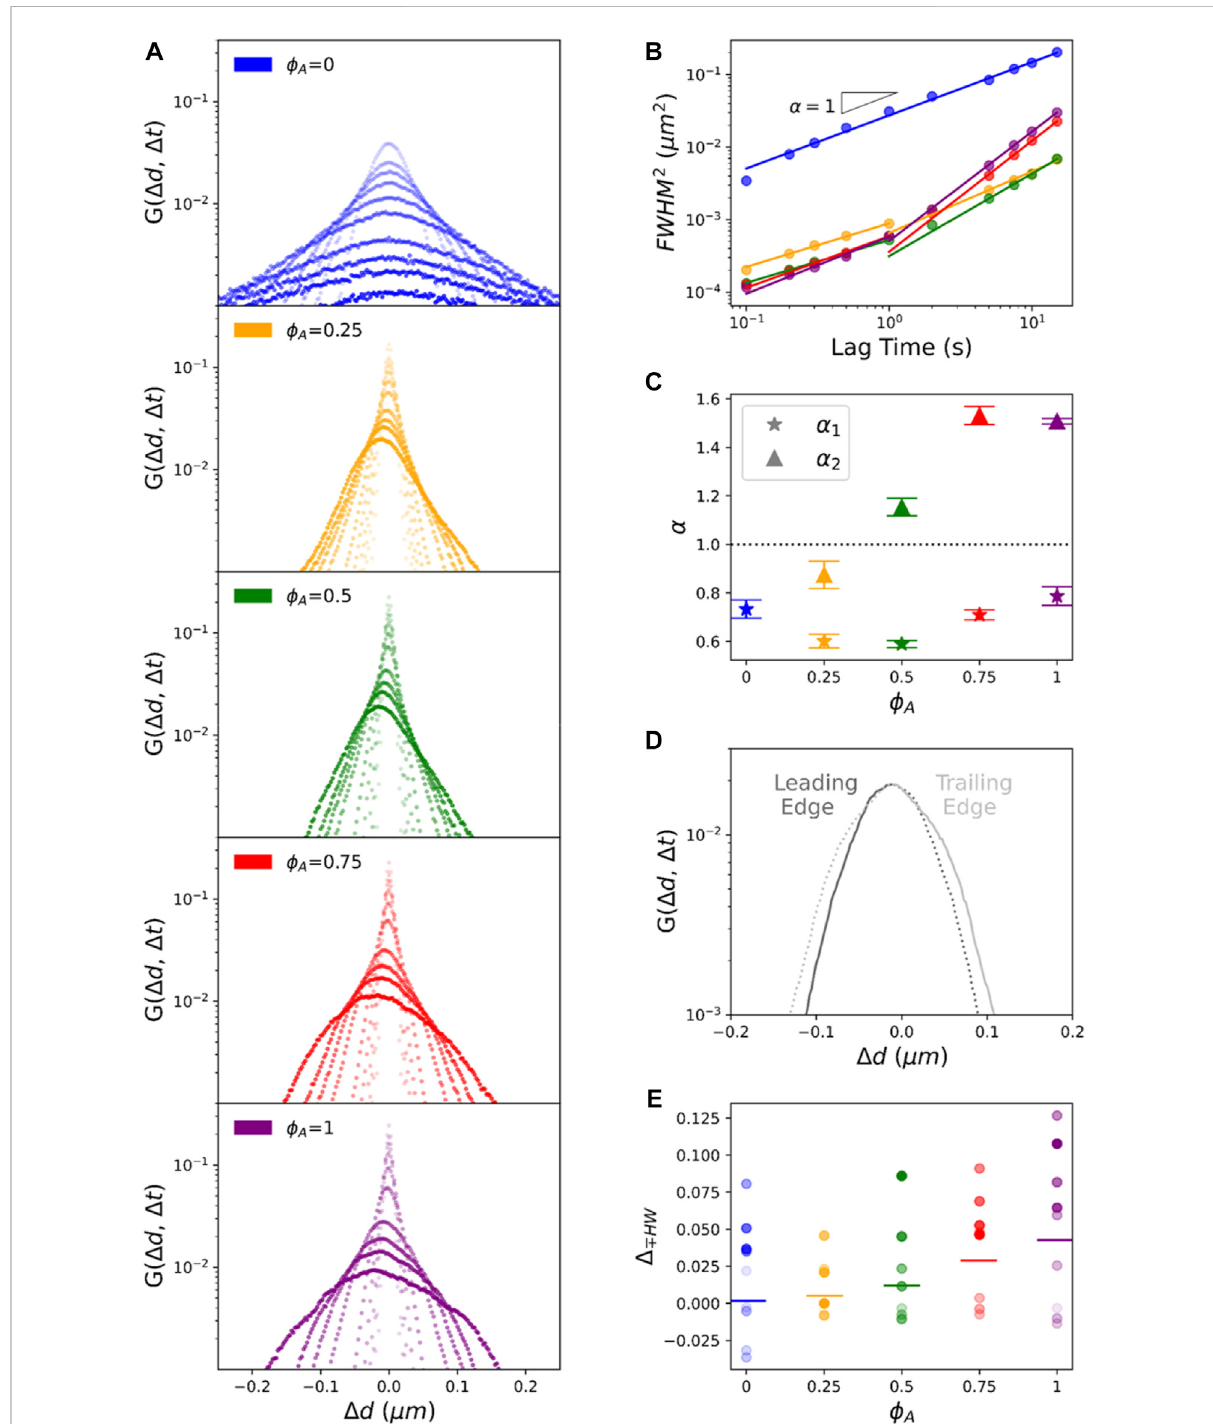
FIGURE 3 Asymmetric non-Gaussian van Hove distributions reveal a combination of heterogeneous subdiffusion and advective transport of particles in active composites. (A) van Hove distributions G ( Δ d , Δ t ) of particle displacements Δ d (cid:2) Δ x ∪ Δ y , measured via SPT, for lag times Δ t (cid:2) 0 . 1 , 0 . 2 , 0 . 3 , 0 . 5 , 1 , 2 , 3 , 5 , 10 , 15 s denoted by the color gradient going from light to dark for increasing Δ t . Each panel corresponds to a different composite demarked by their ϕ A value with color-coding as in Figure 2. (B) The square of the full width at half-maximum ( FWHM ) 2 versus lag time Δ t for each composite shown in (A) . Solid lines are fi ts to ( FWHM ) 2 ~ Δ t α i . For ϕ A > 0 composites we fi t short ( Δ t ≤ 1 s) and long ( Δ t ≥ 1 s) lag time regimes separately. (C) The scaling exponents α as functions of ϕ A determined from the fi tsshownin B,where α 1 (stars) and α 2 (triangles)correspond